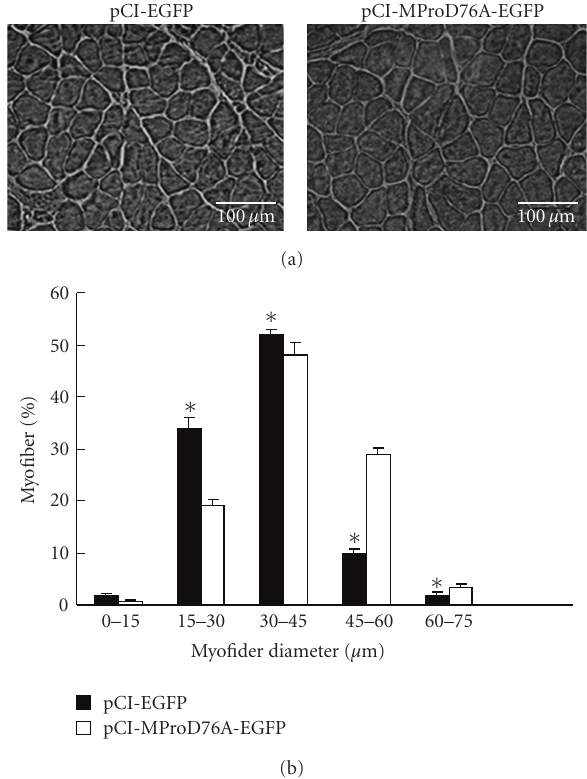
Figure 5: Morphometric analysis of gastrocnemius muscle. (a) H&E staining displays myofiber hypertrophy in muscles injected with pCI-MProD76A-EGFP compared with pCI-EGFP control, Scale bars: 100 μ m. (b) Distribution of muscle fiber sizes in mice injected with either pCI-MProD76A-EGFP or pCI-EGFP. The diameter of 77% pCI-MProD76A-EGFP treated myofibers was measured at 30–60 μ m, whereas that of 86% control myofibers was measured at 15–45 μ m ( ∗ P < . 05, n =